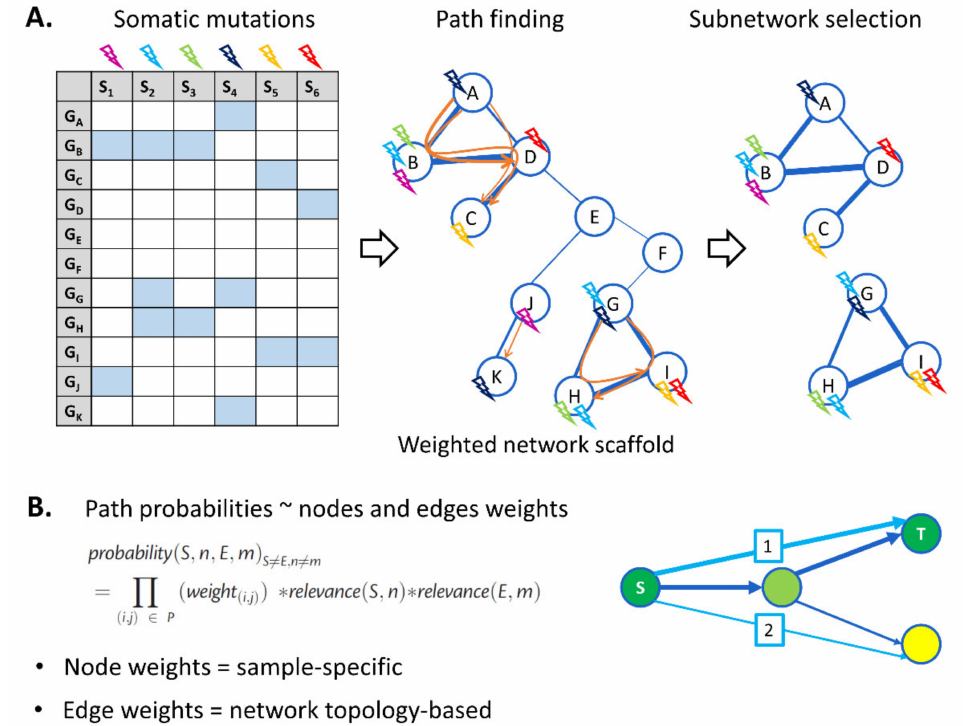
Figure 2. GoNetic workflow. Panel A . GoNetic uses as input somatic mutations of a cohort of tumor samples and a network prior. Somatic mutations occurring in each of the samples are mapped to the genes in the network (mutations occurring in the same sample are represented in the same color). During pathfinding, GoNetic identifies paths between genes that are mutated in different samples, displayed in orange. During the optimization step, GoNetic selects subnetworks that connect as many genes as possible with highly probable paths while using a minimal number of edges. Panel B . To each path, a probability is assigned that is a function of the node and edge weights. Nodes are weighted based on sample-specific information (i.e., the variant allele frequency (VAF), the functional impact score, and the sample mutation rate). Nodes with high weights are indicated in green, and those with lower weights in yellow. Edges are weighted according to the connectivity of the network prior. The line width reflects the edge weight. The example graph illustrates how path 1 will be assigned a higher probability than path 2 because it connects a source (S) to a higher weighted target (T) node and because the edges that make up the paths also have a higher weight than the one used to constitute path